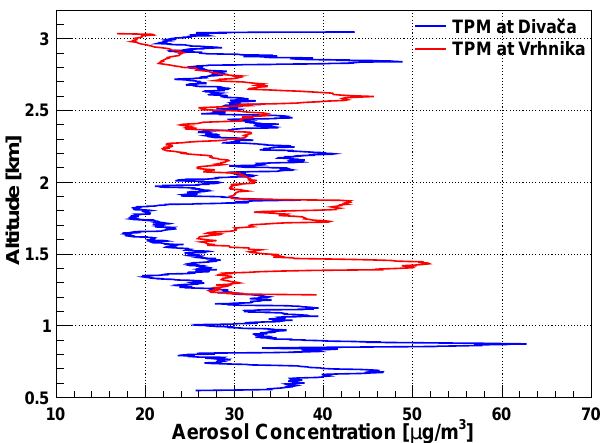
Fig. 9. Profiles of the total particle matter content in the atmosphere above Divaˇca (blue) and above Vrhnika (red) on 20 April 2010 as obtained from the laser particle counter.